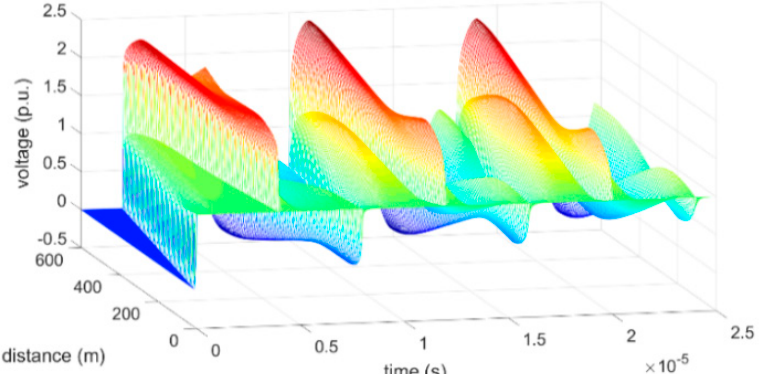
Figure 7. Computed voltage profile along phase A (example 3.1).